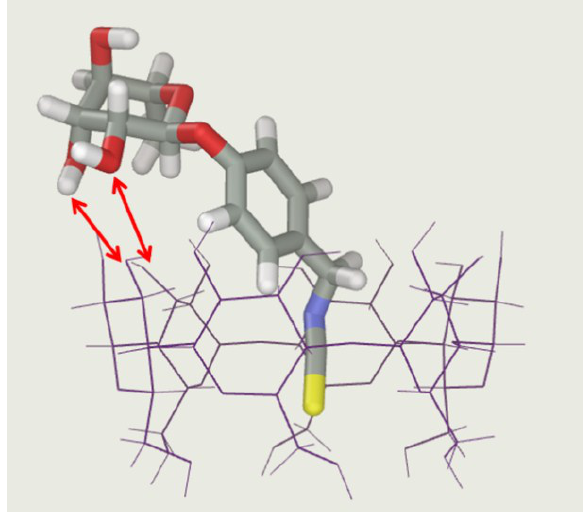
Figure 11. Example of α-CD/MOR conformation extracted from molecular dynamics simulation. Red arrows underline possible hydrogen bonds between MOR and α-CD.